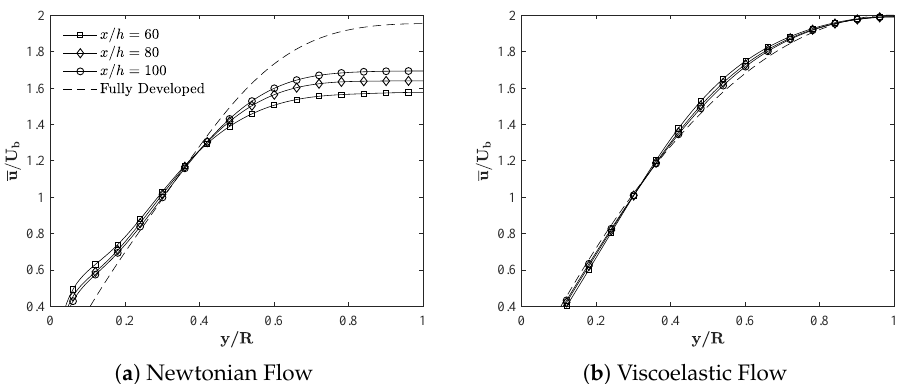
Figure 7. Mean axial velocity profiles ( u / U b ) at different axial locations ( x / h = 60,80 and 100) for h / D =